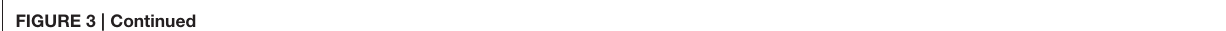
progressive TarP deletion derivatives (TirM-TarP1-714 or TirM-TarP-1-639), or the TirM control were infected with 1 tir EPEC to induce clustering of the fusion protein. Transfected cells were identified by their ability to bind 1 tir EPEC. The white arrowheads indicate colocalization of vinculin (red) with 1 tir EPEC (blue). Vinculin